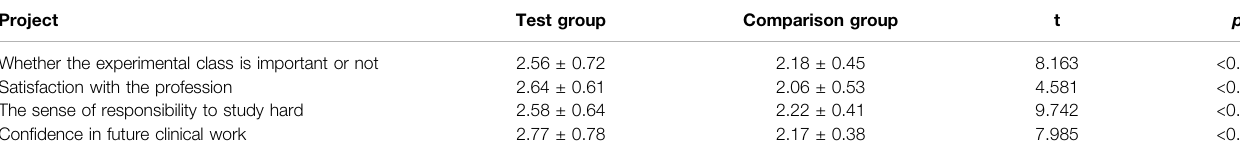
TABLE 3 | Comparison of the overall attitudes of the two groups of students to the experimental class.